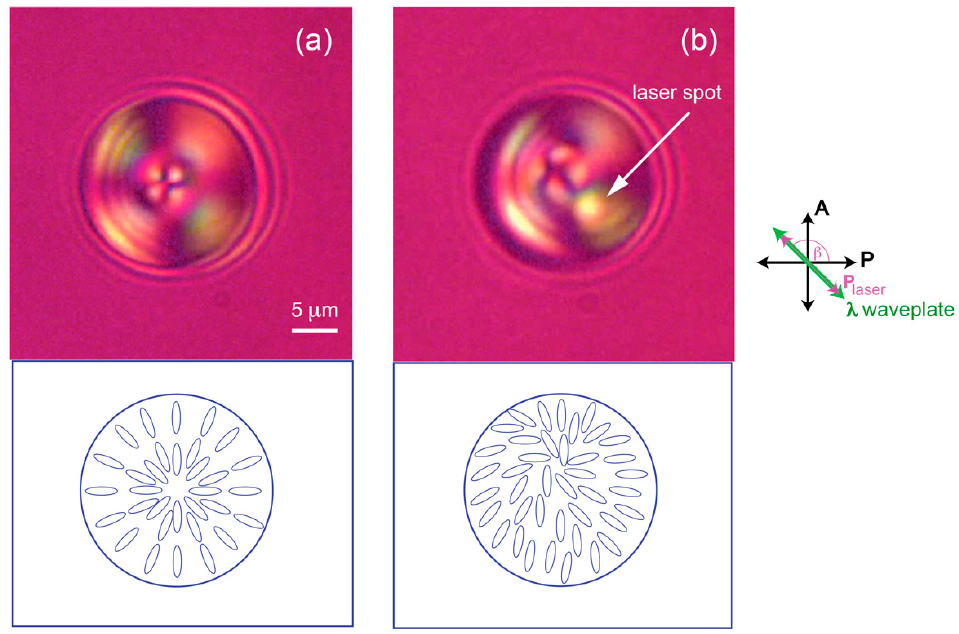
Figure 2. Microscopic images taken under crossed polarizers and a one-wavelength plate inserted diagonally for director orientation mapping. ( a ) A 19- μ m radial NLC droplet suspended in water. The droplet configuration is spherically symmetric, the so-called ‘radial hedgehog’. ( b ) By applying the linearly polarized laser onto the droplet, the defect in the middle shifted slightly to the side along the polarization direction of the laser, β = 135° with respect to a horizontal direction. This distorted configuration caused by the alignment of the molecules in the laser beam pointed toward the laser polarization direction, thus pushing the defect to the side.